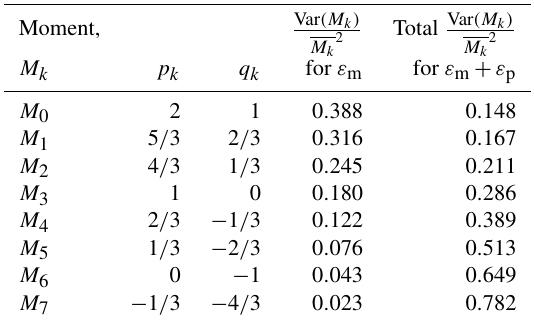
Table A1. Variance estimates for the radar-based retrievals of mo- ments M 0 through M 7 . The p and q are the exponents of M k = − q M p M . The normalized variances due to measurement errors are 3 6 given in the 4th column, while the totals due to measurement and parameterization errors are given in the 5th